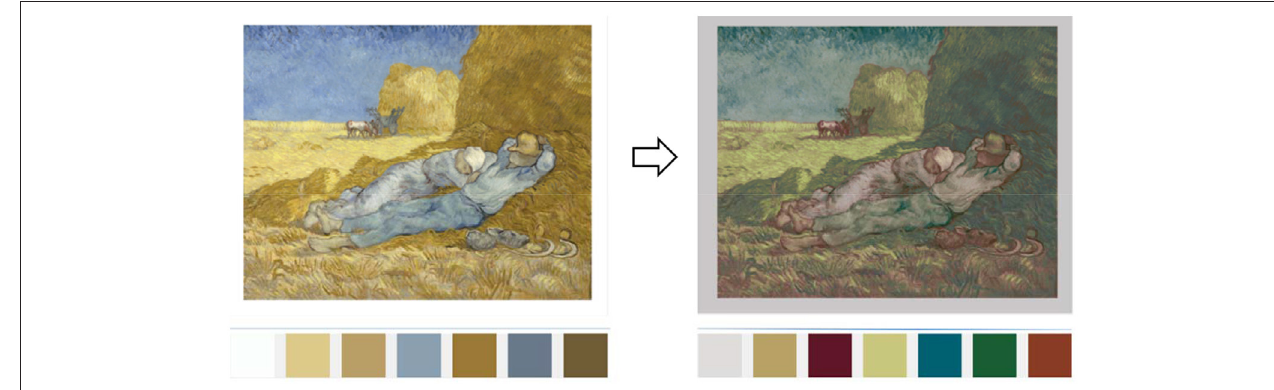
FIGURE 5 | The transformation of original painting to the derivative image.